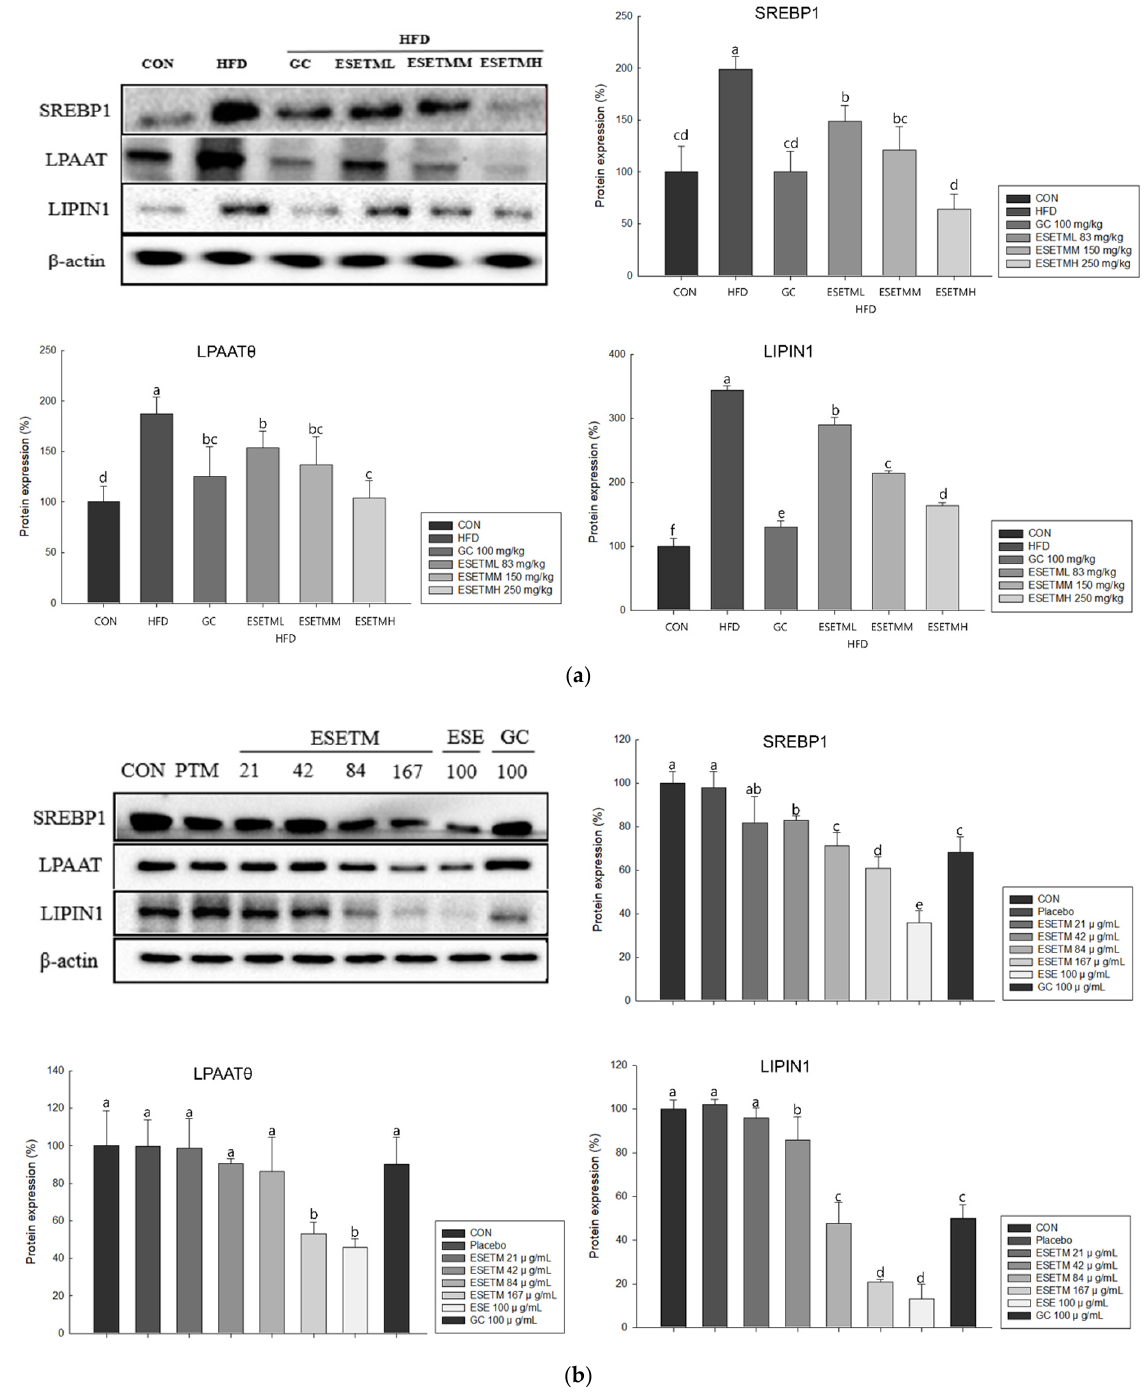
Figure 5. Effects of ESETM lipogenic protein expression in ICR mice fed HFD after 7 weeks and adipocytes treated with ESETM. ( a ) Western blots of lipogenic proteins in WAT. ( b ) Western blots of lipogenic proteins in adipocytes. Data are shown as the means ± standard deviation (SD) ( n = 5). Different lower case letters above columns indicate statistical differences at p < 0.05.